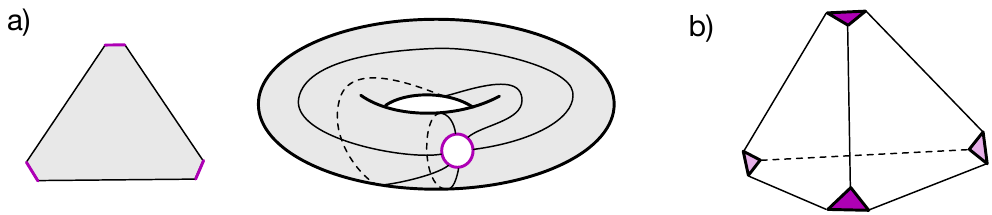
Figure 4 . a) An ideal triangle, and an ideal triangulation of a punctured 2-torus into two ideal triangles; b) an ideal